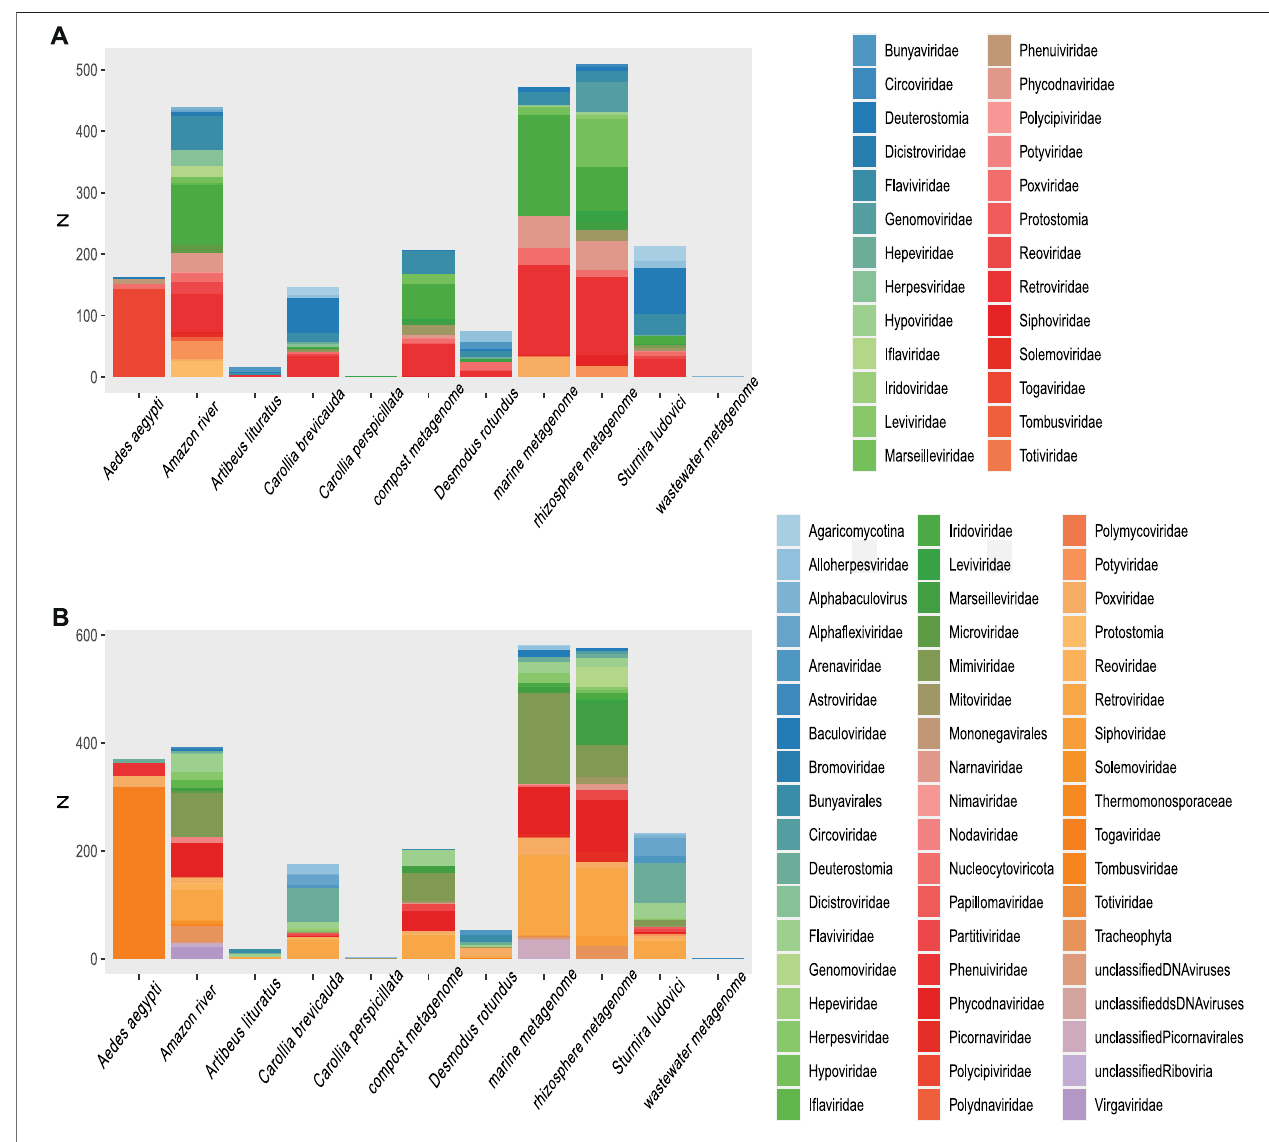
FIGURE 7 | Proportion of contigs obtained related to viral proteins in each metagenome of organisms. The colors allow to identify in the horizontal bars the proportion of sequences related to viral proteins ( x -axis) according to the viral family ( y -axis) in each animal model.